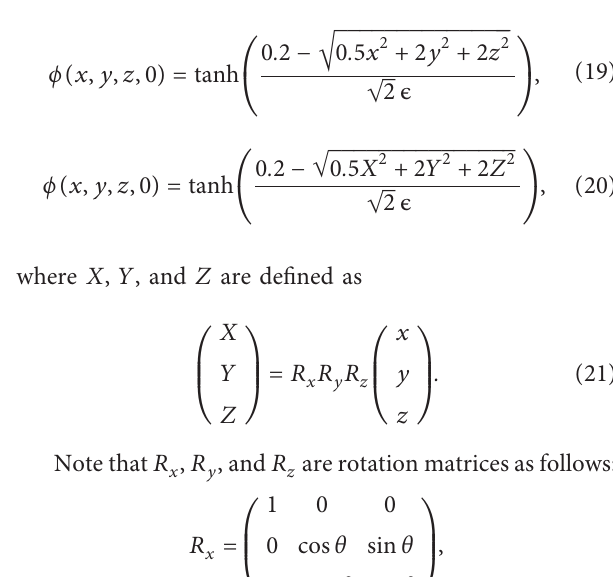
Figure 6: (a–d) Snapshots of zero-level contours for evolution in (16) using the standard scheme at t � 0, 15000 Δ t , 35000 Δ t , and 50000 Δ t , respectively. (e–h) Snapshots of zero-level contours for evolution in (17) using the standard scheme at t � 0, 15000 Δ t , 35000 Δ t , and 50000 Δ t , respectively. (i–l) Overlapped zero-level contours for each column at t � 0, 15000 Δ t , 35000 Δ t , and 50000 Δ t ,